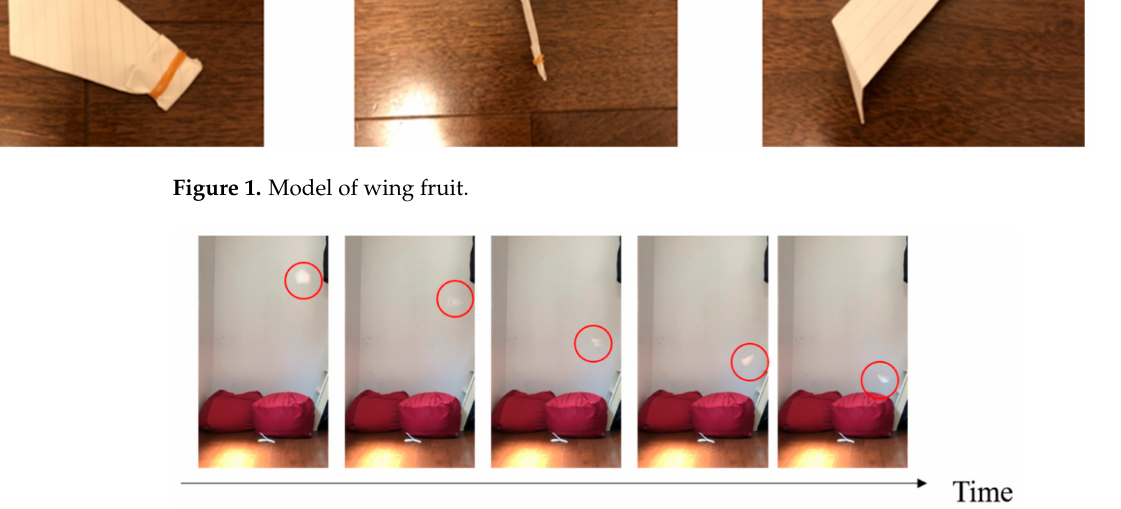
Figure 2. Falling test of the model of the maple tree.